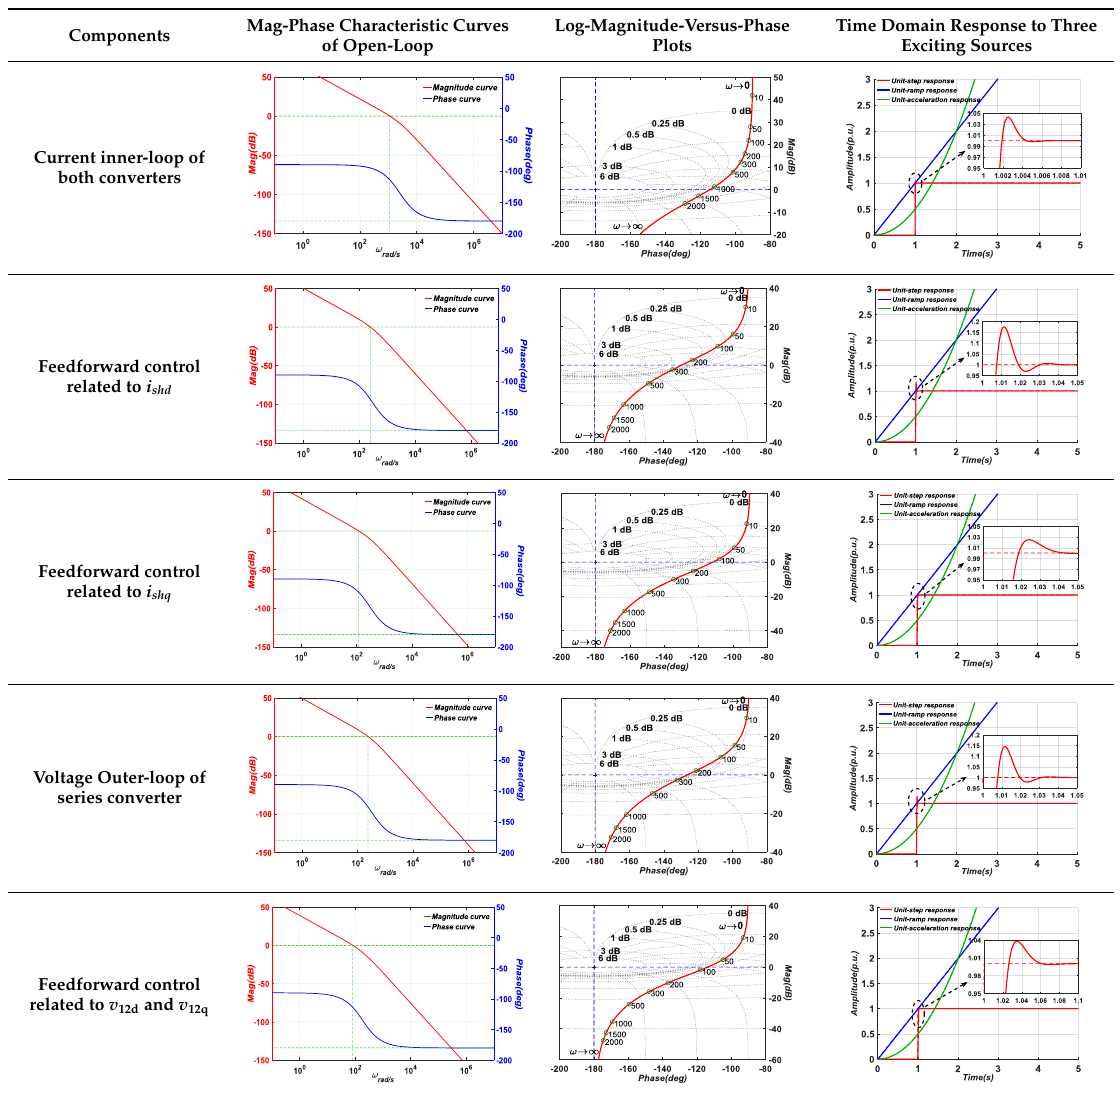
Table A1. Figures of characteristics performance of all the designed control components. Components